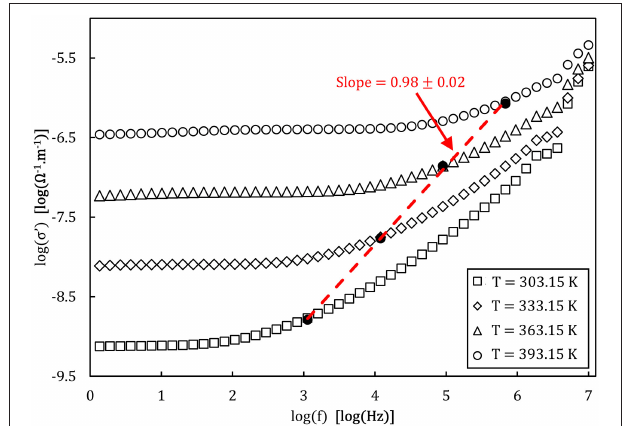
FIGURE 7 | Nyquist plot of the complex impedance measured for the 90NaPO 3 -10NaCl glass at different temperatures. The empty symbols show the experimental data and the continuous line is the fit to the equivalent circuit shown in the inset.